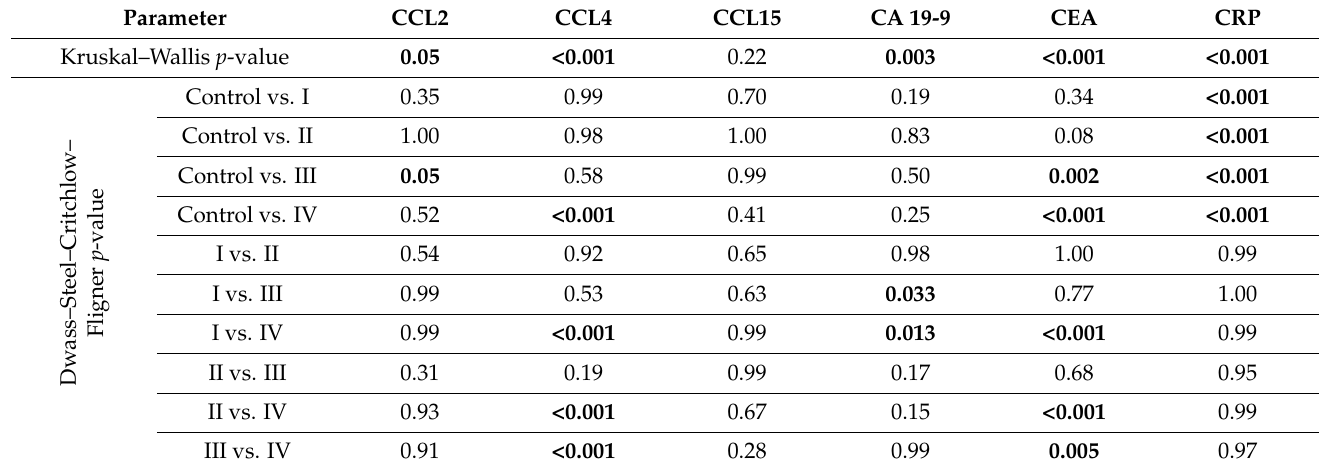
Table 3. Kruskal–Wallis and Dwass–Steel–Critchlow–Fligner tests analysis results.